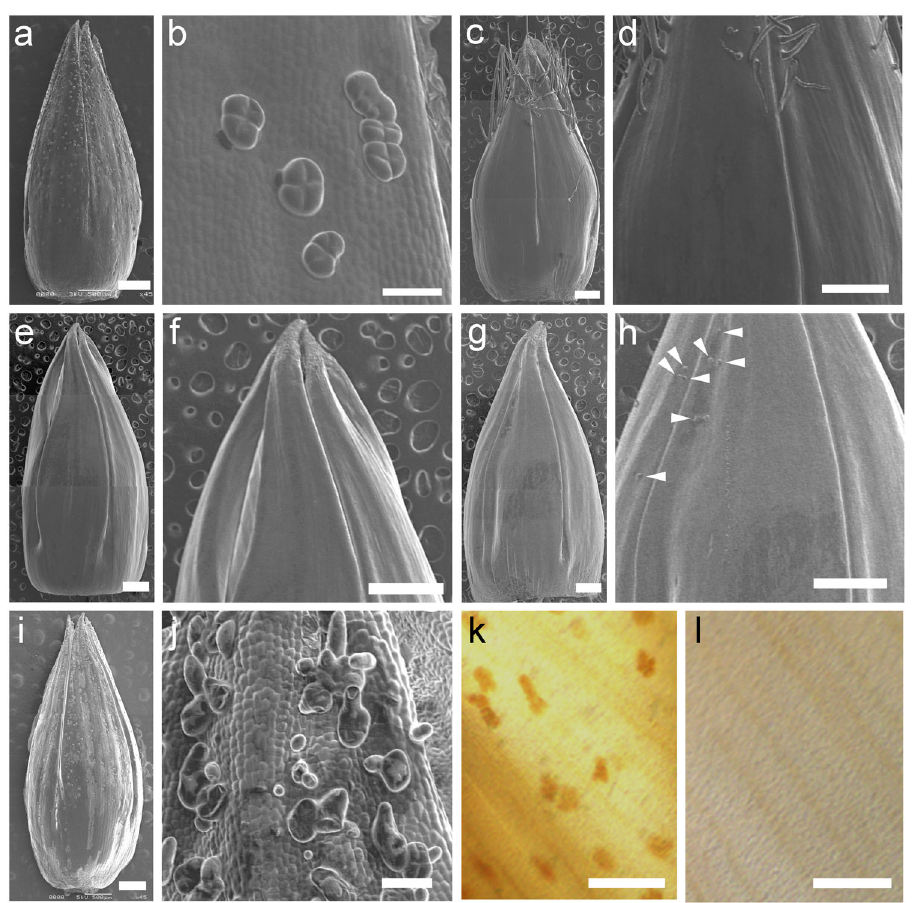
Fig. 3 Glandular secretory trichomes on the abaxial side of a morning glory corolla. a , b Tokyo Kokei Standard (TKS) corolla with glandular trichomes. c , d Q513 corolla without glandular trichomes. Note that hairy trichomes develop at the distal part of the corolla. e , f Q532 corolla without glandular trichomes. g , h Q1096 corolla with tiny structures (arrowheads). i , j Q1141 corolla with deformed glandular trichomes. k , l Corolla of Q1118 ( k ) and Q1141 ( l ) treated with clearing solution, showing that glandular trichomes are densely stained in Q1118 but that no such structures are present in Q1141. Scale bars: a , c , e , g , i , 500 µ m; b , d , f , h , j , 50 µ m; k , l , 100 µ